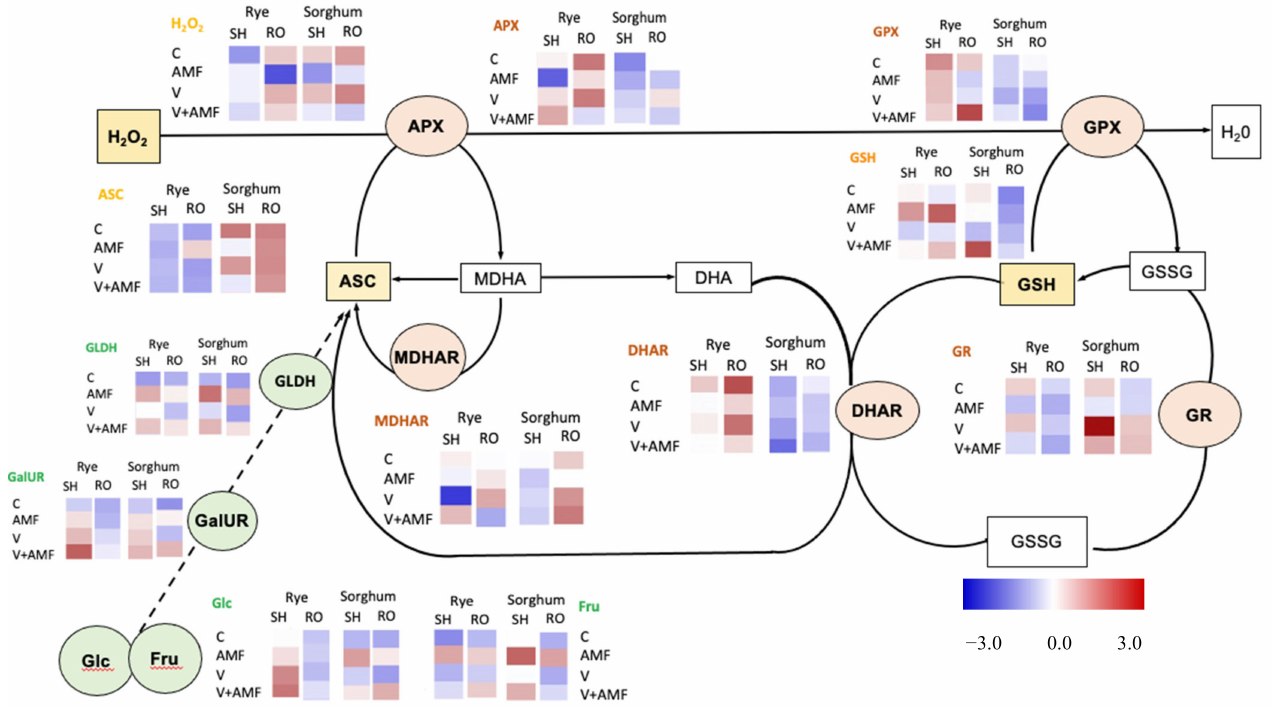
Figure 5. Changes in ascorbate-glutathione cycle enzymes and metabolites, glucose, fructose and two key enzymes in the metabolizing sugars into ascorbate in shoots and roots of six-week-old rye and sorghum grown in soils with 0 or 350 mg/kg soil sodium vanadate and with or without soil enrichment with inoculum of the mycorrhiza Rhizophagus irregularis